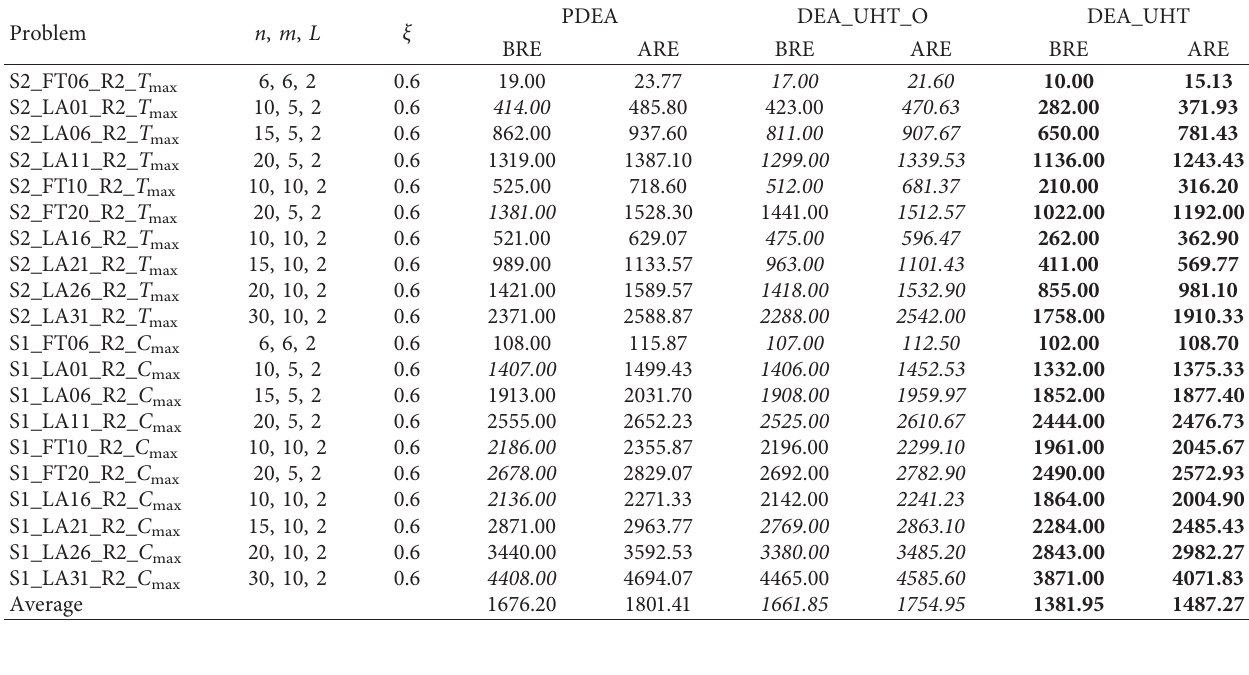
Table 3: Comparisons of PDEA, DEA_UHT_O, and DEA_UHT on two other kinds of stochastic RJSSP. PDEA Problem n , m , L ξ